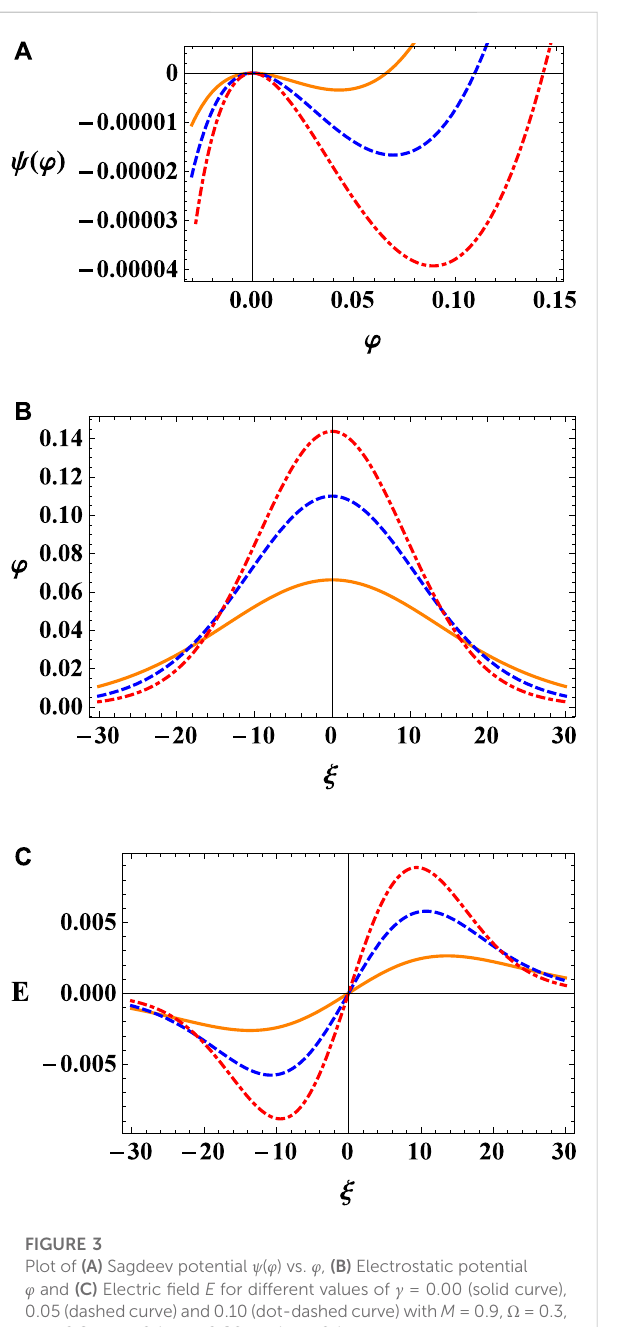
FIGURE 4 Plot of (A) Sagdeev potential ψ ( φ ) vs. φ , (B) Electrostatic potential φ and (C) Electric fi eld E for different values of p (cid:3) = 0.20 (solid curve), 0.25(dashedcurve)and0.30(dot-dashedcurve)with M =0.9, Ω =0.3, γ = 0.2, p ⊥ = 0.1, α = 0.80, and σ =